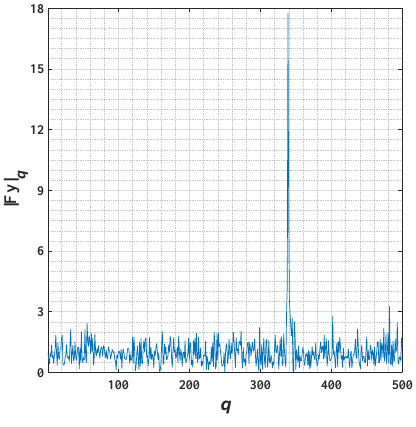
Figure 2. | Fy | q , q = 1,2, . . . , M , SNR =